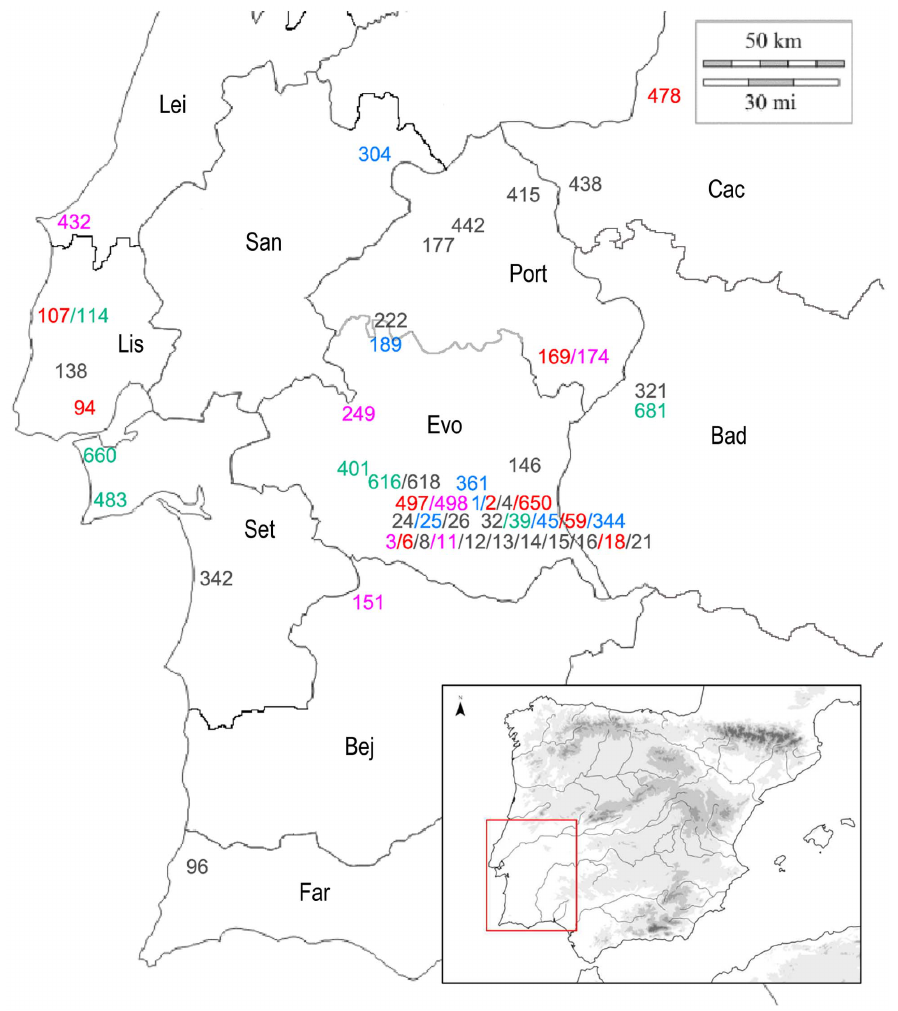
Figure 4. Distribution map of the four data sets. Sample 1: red; sample 2: green; sample 3: blue; and sample 4: pink. Gray numbers reference plaques that belong to more than one sample. The names of Portuguese districts are Leiria (Lei), Lisboa (Lis), Setu´bal (Set), Beja (Bej), Faro (Far), E´vora (Evo), and Portalegre (Port), and the Spanish provinces are Ca´ceres (Cac) and Badajoz (Bad).